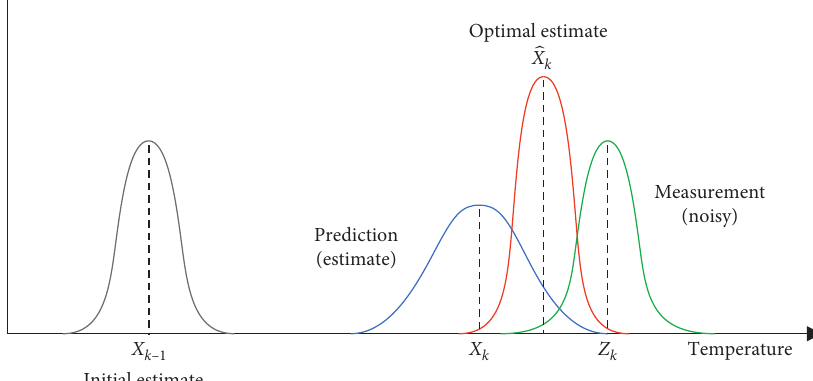
Figure 5: The working principle of Kalman filter from time k − 1 to time k.